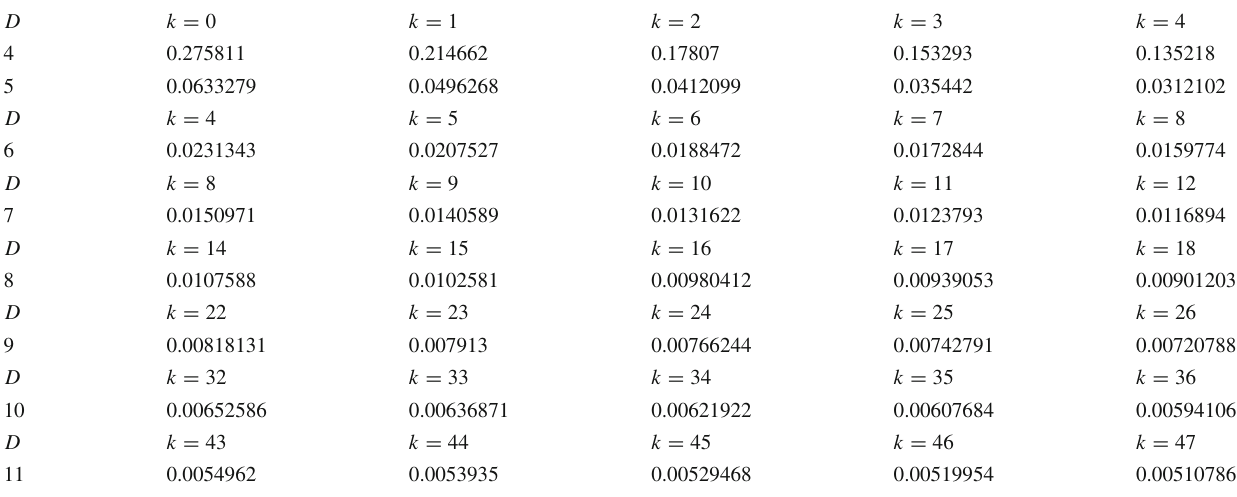
Table 2 θ max values for different k and D